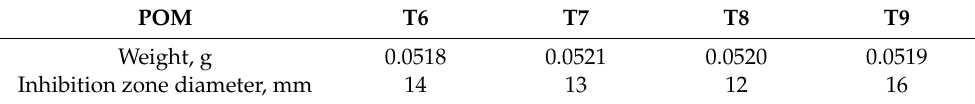
Table 5. The results of POM agar diffusion test against E. coli